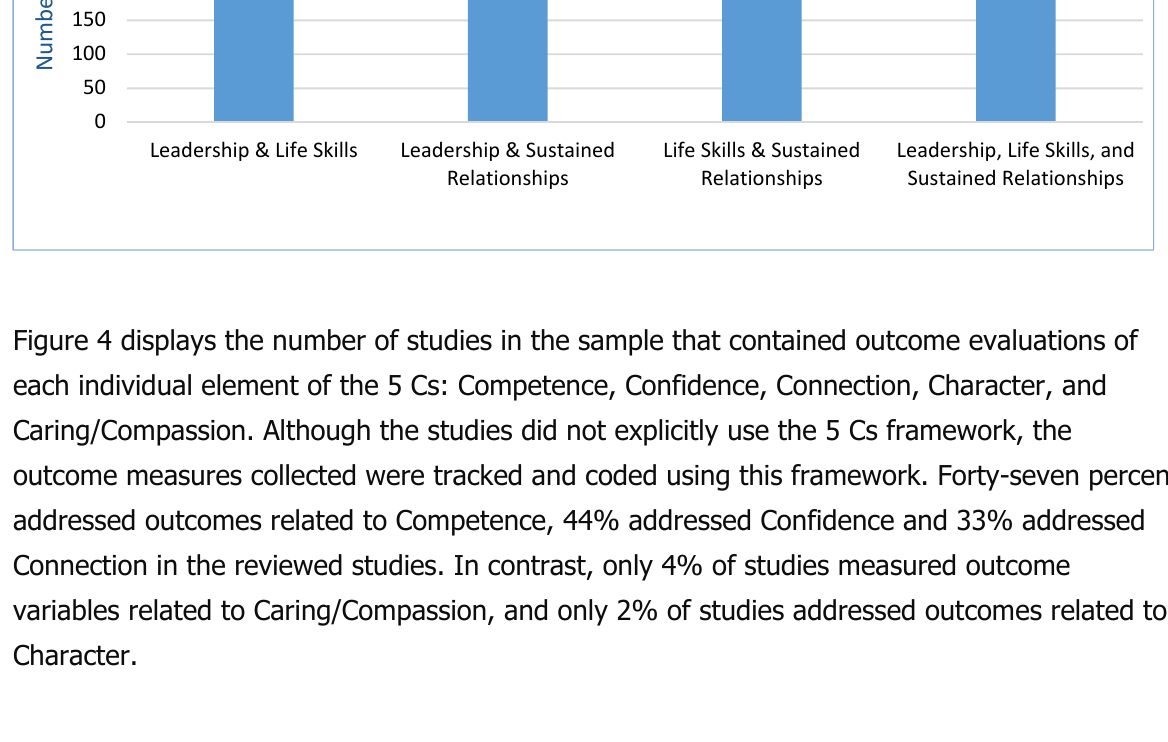
Figure 4. The Number of Studies Containing Each 5 C